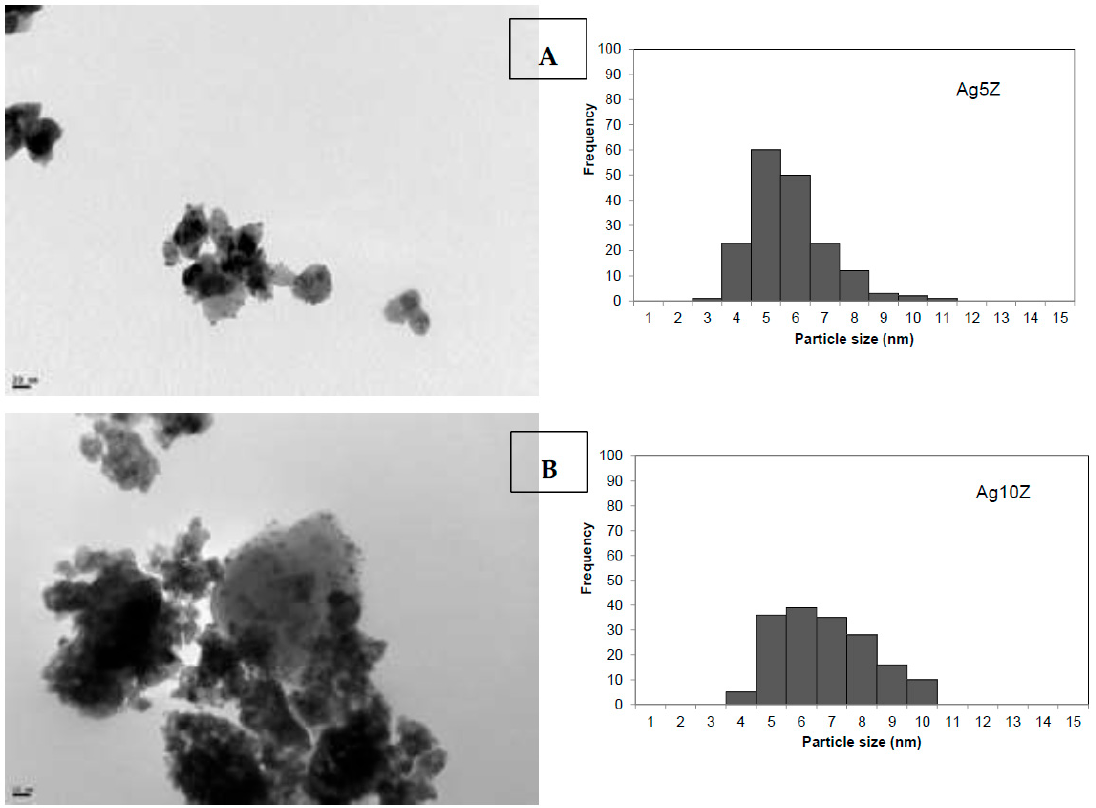
Figure 6. TEM micrographs and histograms of particle size distribution: ( A ) Ag5Z catalyst; ( B ) Ag10Z catalyst.